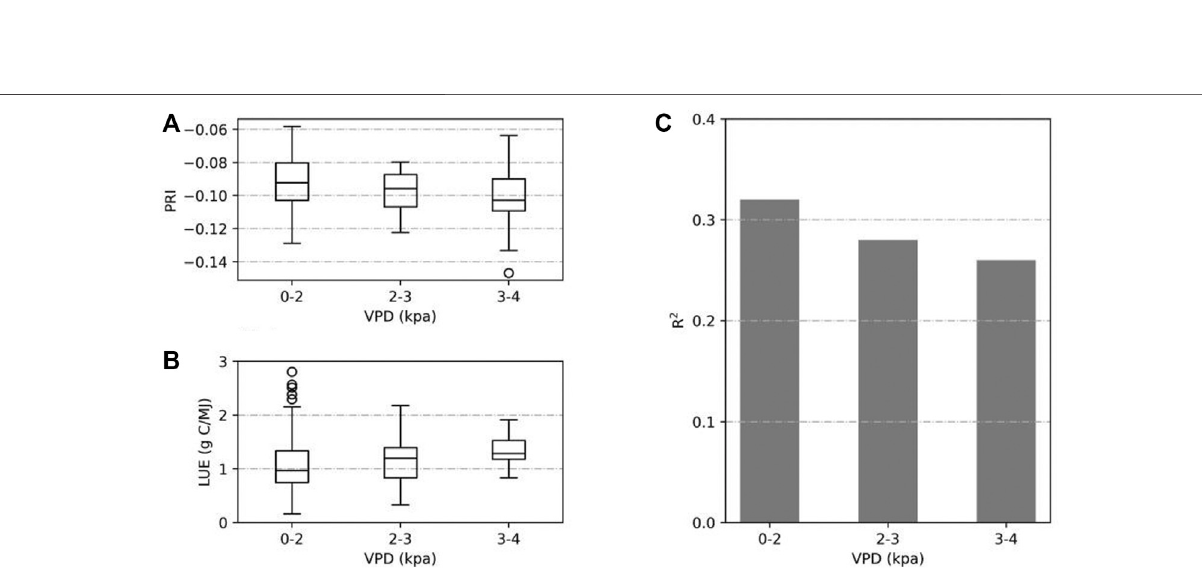
Frontiers in Earth Science |